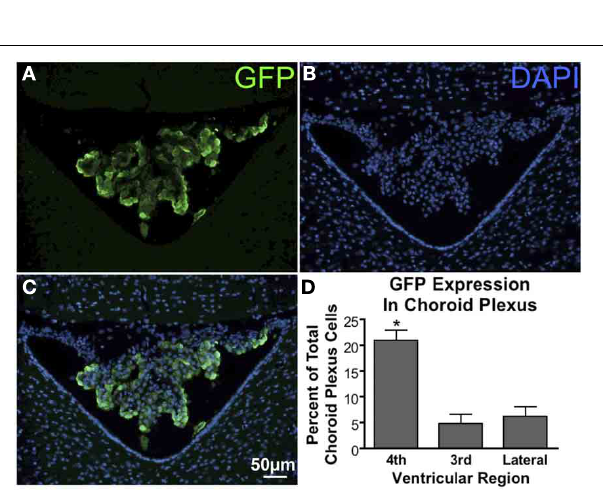
FIGURE 10 | GFP expression in the choroid plexus. (A) GFP-ir in choroid plexus of the 4th ventricle. (B) DAPI staining in the same section showing cellular nuclei in the choroid plexus (center), cerebellum (top), and medulla (bottom left and right). (C) Overlay of images in (A) and (B) showing a substantial portion of the choroid plexus cells to be transduced. (D) Graph illustrating that transduction of choroid plexus cells is significantly higher in the 4th ventricle compared to the third and lateral ventricles. ∗ Indicates significance as determined by one-way ANOVA followed by Bonferroni post-hoc analysis, ( p < 0 . 001, n = 4). Across all animals and ventricles 35,071 nuclei were counted, 3708 of which were identified as